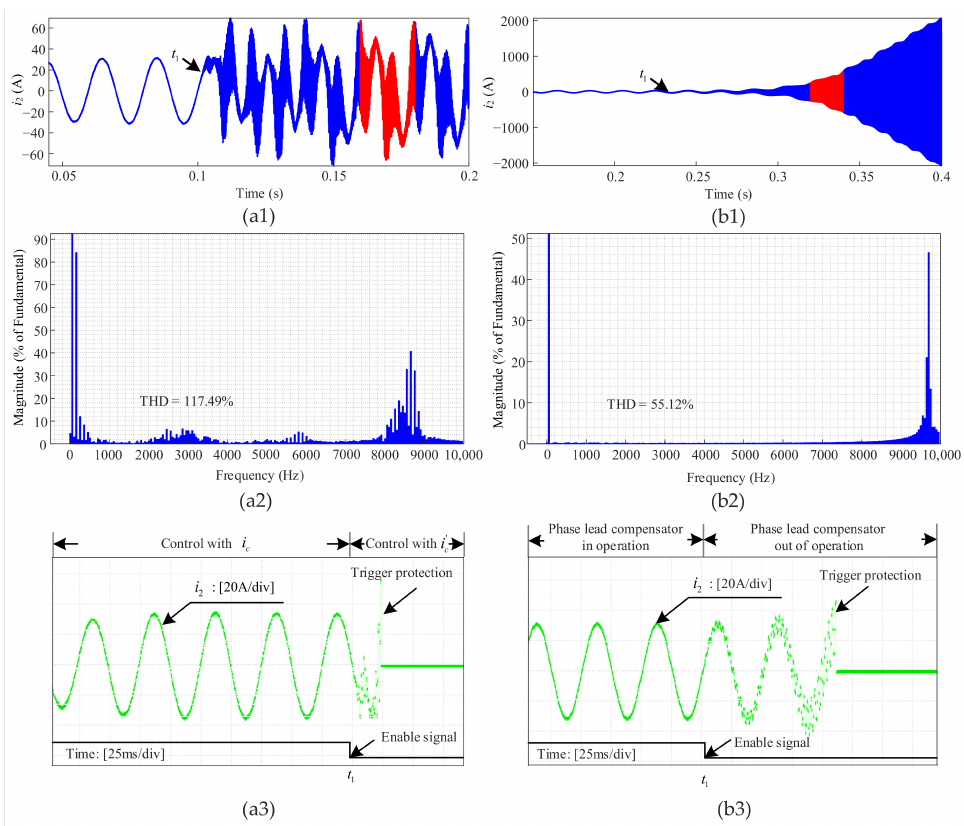
Figure 28. Simulation and experimental results of case 1 and case 2: ( a1 , a2 ) Simulation results of the grid-side current i L 2 and its FFT analysis for case 1; ( b1 , b2 ) simulation results of the grid-side current i L 2 and its FFT analysis for case 2; ( a3 , b3 ) experimental results of the grid-side current i L 2 for case 1 and case 2,